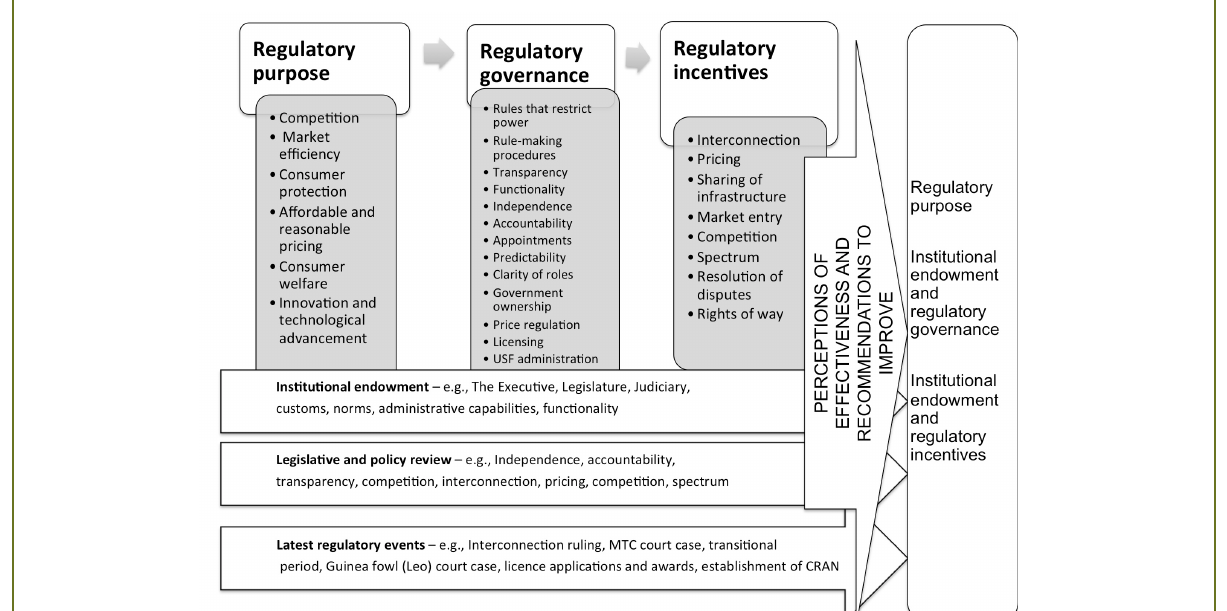
FIGURE 1: CONCEPTUAL FRAMEWORK FOR ASSESSING PERCEPTIONS OF